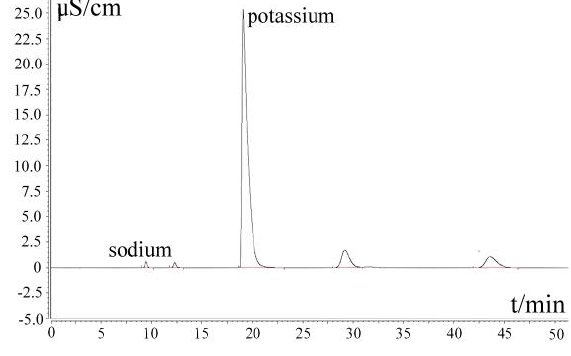
Table 1. Chloride and sulphate concentrations,